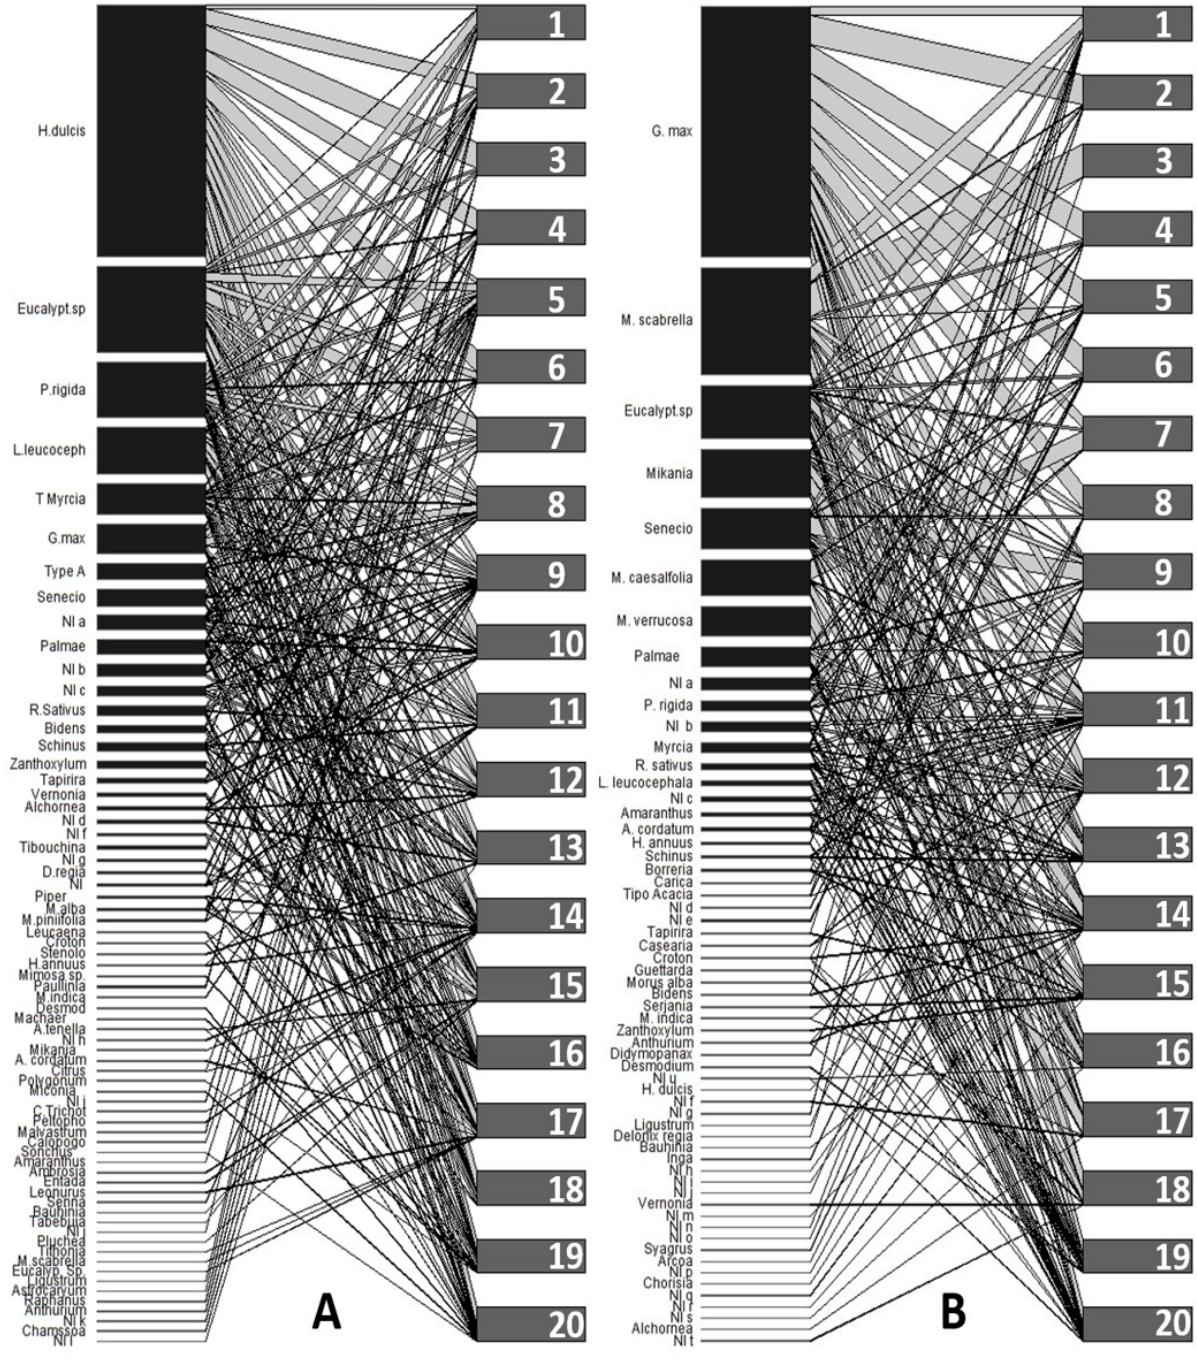
Fig 3. Quantitative bipartite network among pollen types identified in different honey samples. The binary matrix (A) represents the honey samples from Santa Helena and (B) samples of honey collected in Terra Roxa. Each black rectangle represents species of plants (left) and samples of honey from the counties (right). The lines between the columns indicate the number of pollen types in each sample, and the width of each rectangle on the left indicates the pollen frequency in all